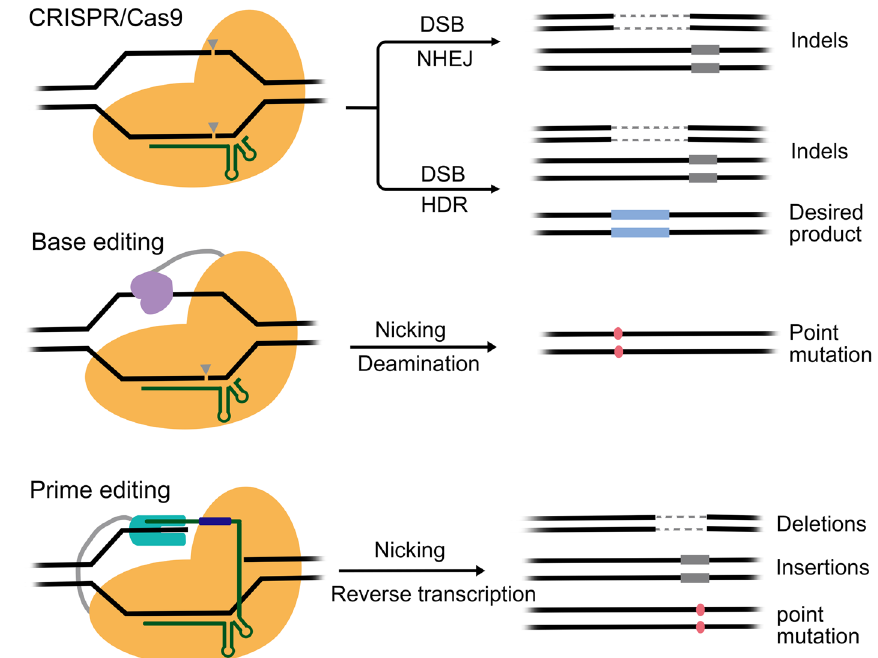
Fig. 2 Editing processes outcomes of Cas9 nuclease, base editor and prime